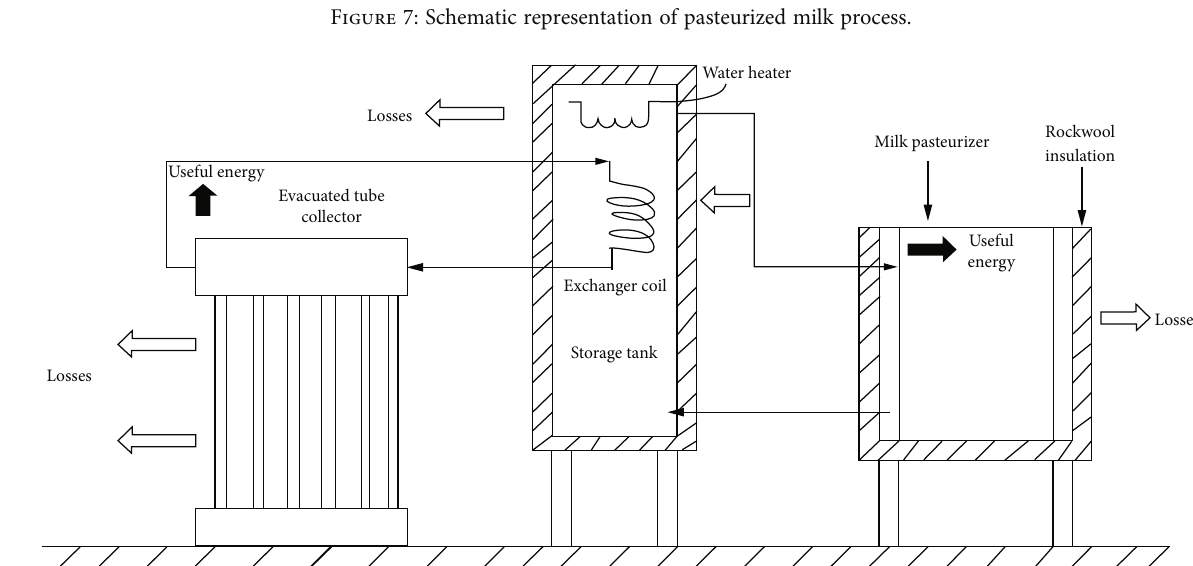
Figure 8: Milk pasteurization working process by using evacuated tube